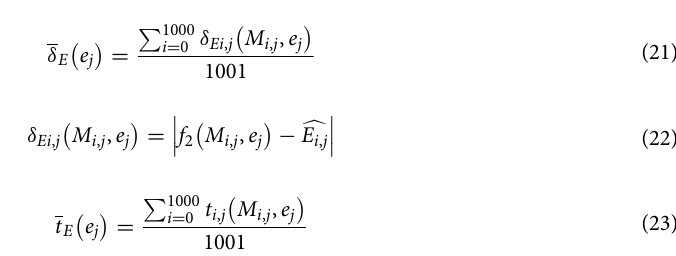
Figure 11. Compared with SICAA analytic solution, average numbers of iteration of standard Newton– Raphson method and Halley’s method, which are averaged with respect to M ∈ [0, π ] ,